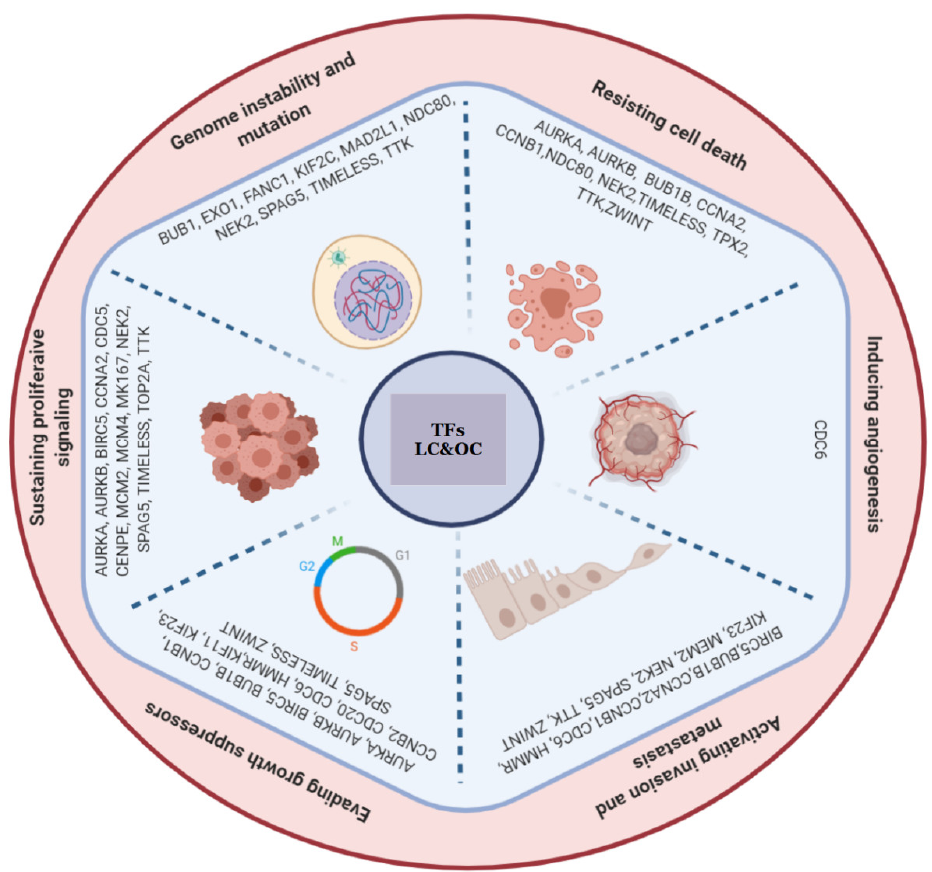
Figure 8. Hallmarks of cancer related to the genes of the LC&OC coexpression network.